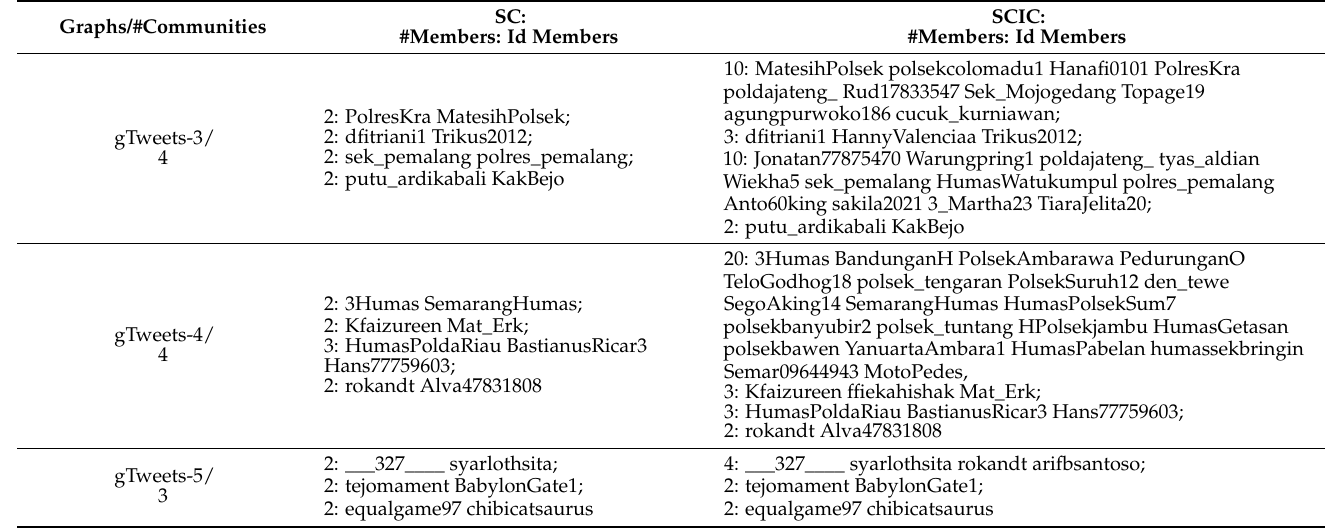
Figure A2. Some part of the filtered weighted graph of 7–13 March 2021 period. Table A1. SC and SCIC Communities of 3